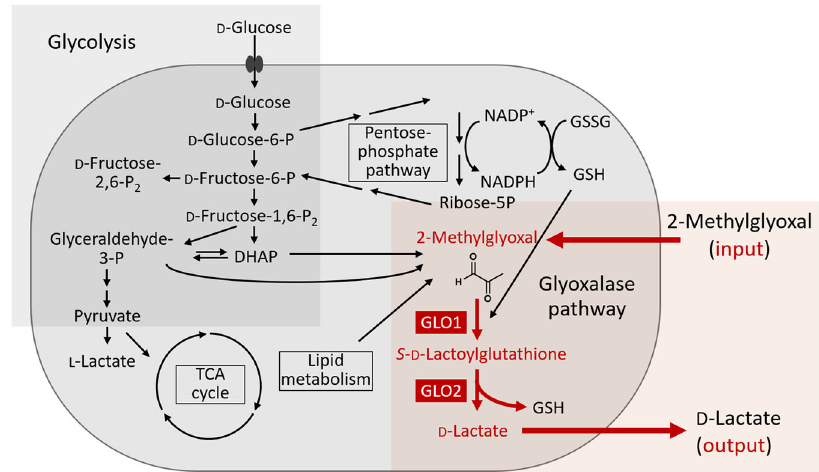
Fig. 1 Design of metabolic pathway-oriented screening to control glyoxal metabolic pathway. Targeted pathway connecting the input and output metabolites used for the screening (2-methylglyoxal and D -lactate) is shown in orange rectangle, and the important intermediate metabolites are shown in red